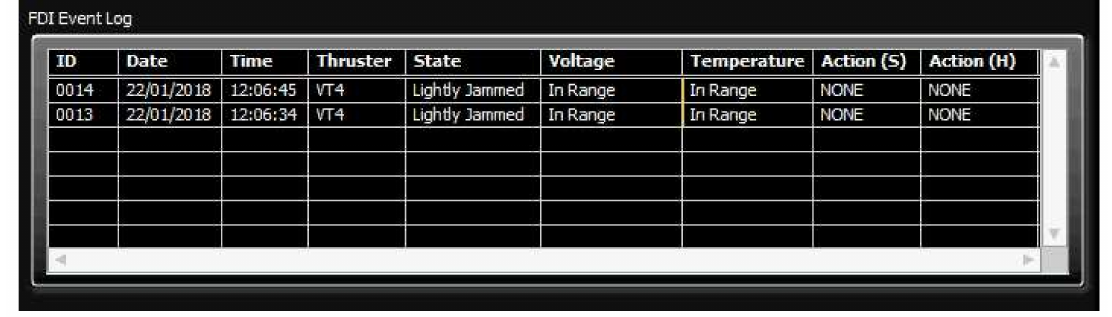
Figure 14. Thruster Fault Detection and Isolation (FDI) Event Log